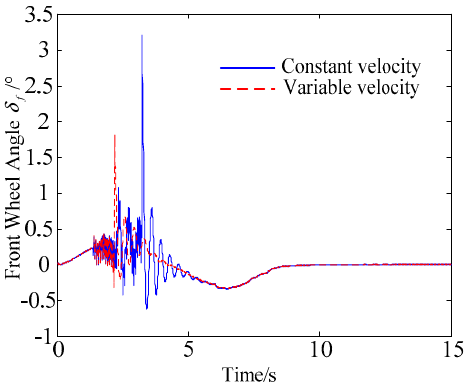
ff erent velocities of vehicle q . Sensors 2020 , 18 , x FOR PEER REVIEW